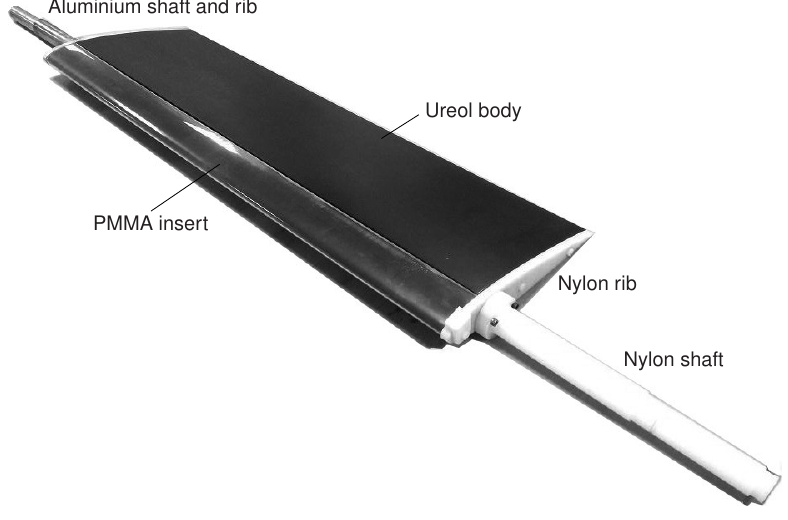
Figure 1. NACA0015